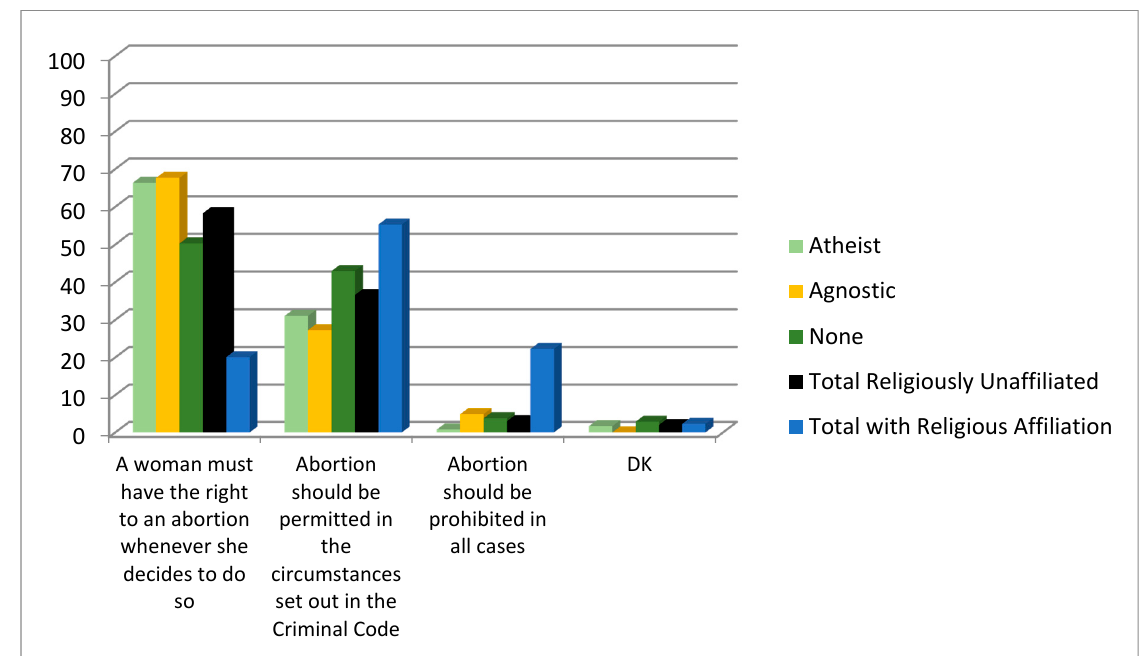
Figure 6. Opinion on abortion (in %). Based on 2421 cases. Source: Author’s elaboration based on the Second National Survey on Religious Beliefs and Attitudes. Society, Culture and Religion Program, CEIL-CONICET, 2019.